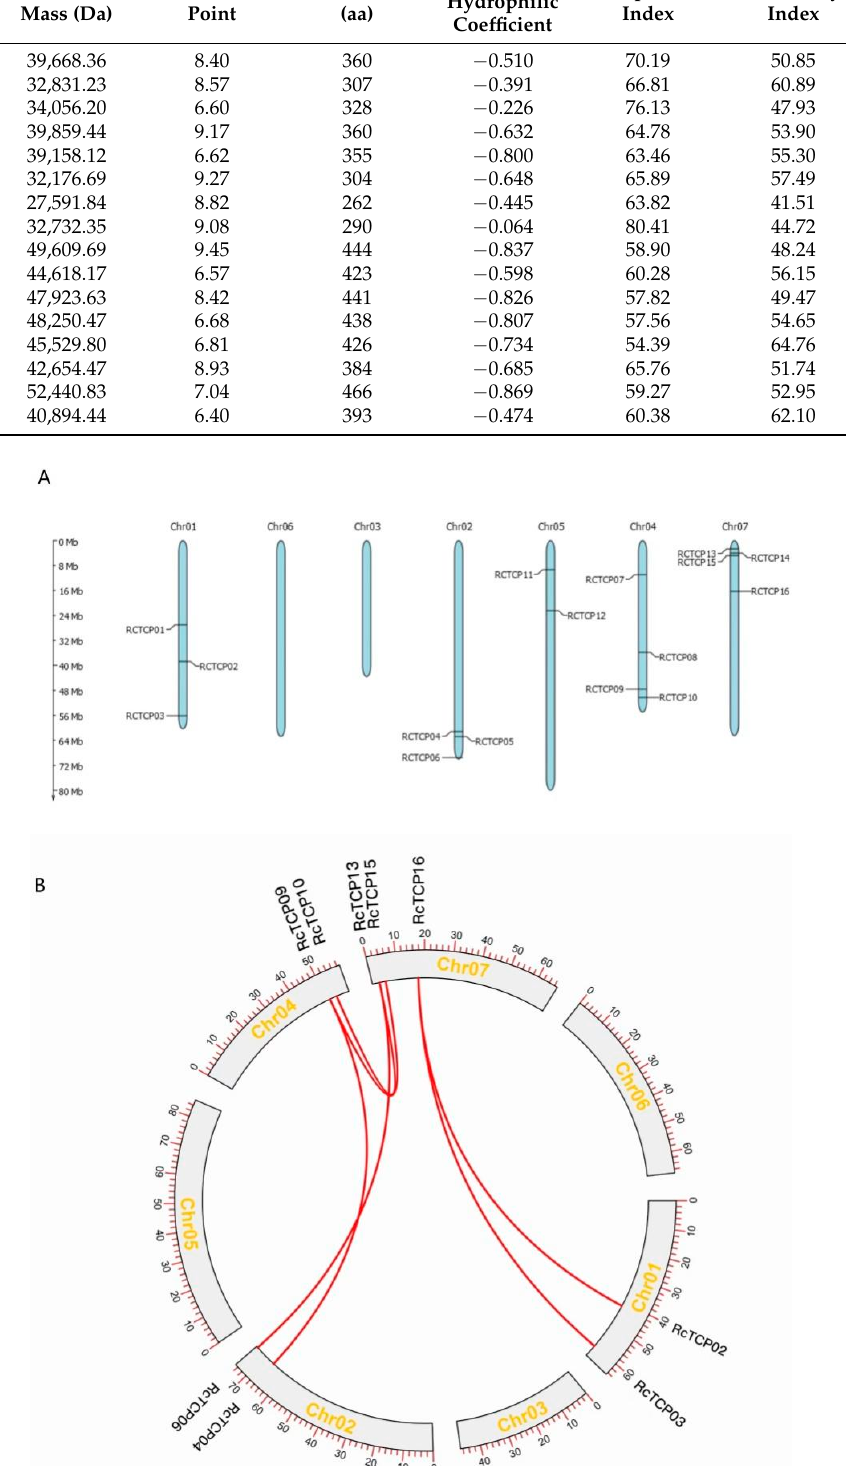
Figure 1. Distribution on chromosomes and homology analysis of RcTCP gene family. ( A ) The distribution of RcTCP gene family on chromosomes; ( B ) The chromosome distributions and syntenic analysis of RcTCP genes. The approximate positions of RcTCP gene were marked on the circle. The red curve denotes the syntenic relationships between RcTCP genes.